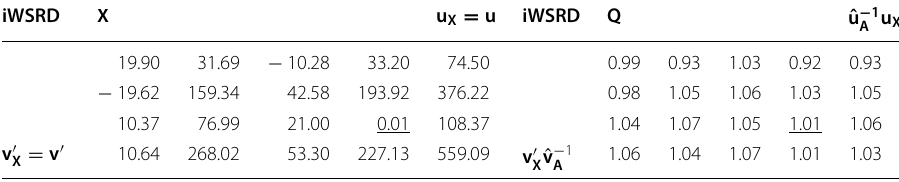
With the same location of underlined matrix elements as in Table 18